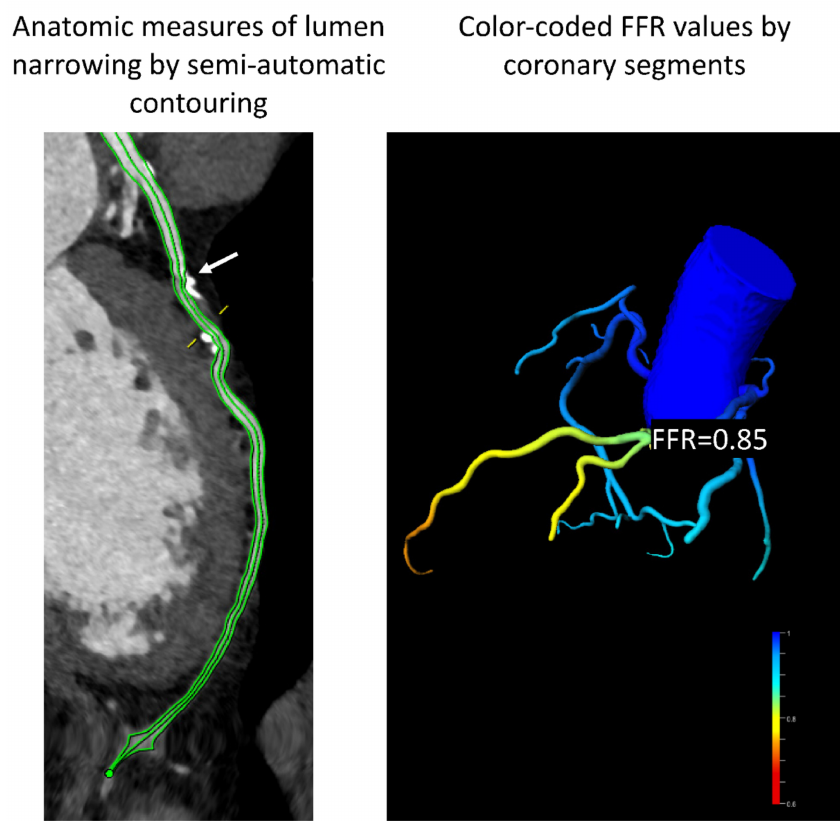
Figure 9. Example of FFR CT analysis (research software: syngo.via Frontier cFFR, Siemens Healthineers). The analysis is used for scientific and not for clinical purposes. Analysis performed on the entire coronary tree. Note a moderate plaque in the proximal LAD, which revealed a FFR CT value of